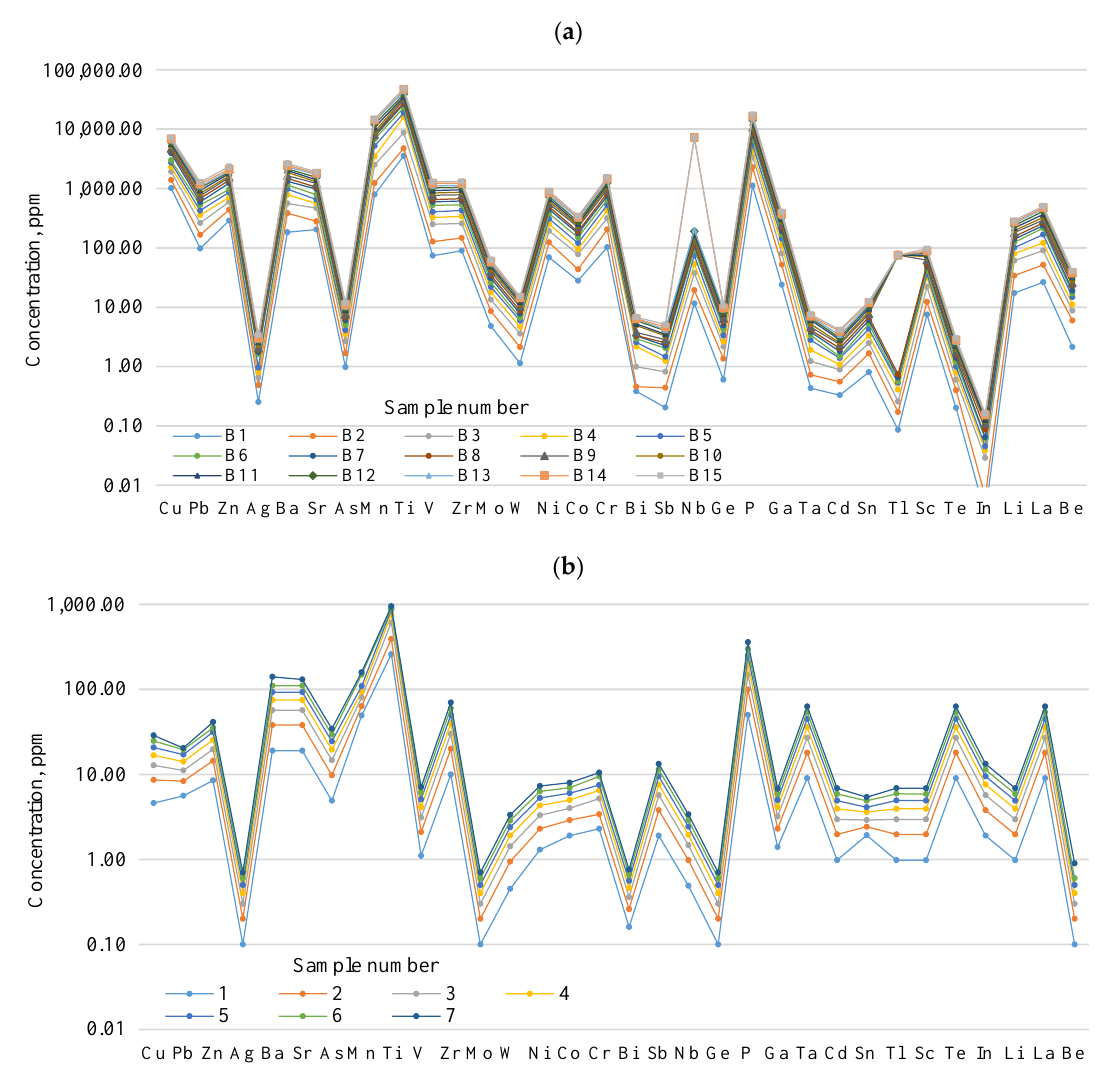
Figure 5. Distribution of microcomponents within Burabay rock mass: ( a )—in water (15 samples, lakes); ( b )—in the bottom sediments (15 samples, B1–B15); ( c )—in granites (7 samples).